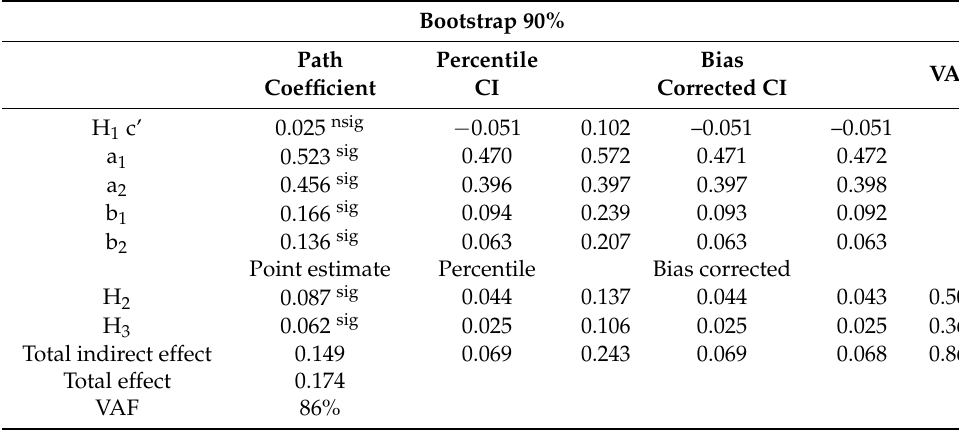
Table 8. Multiple mediation. VAF, variance accounted